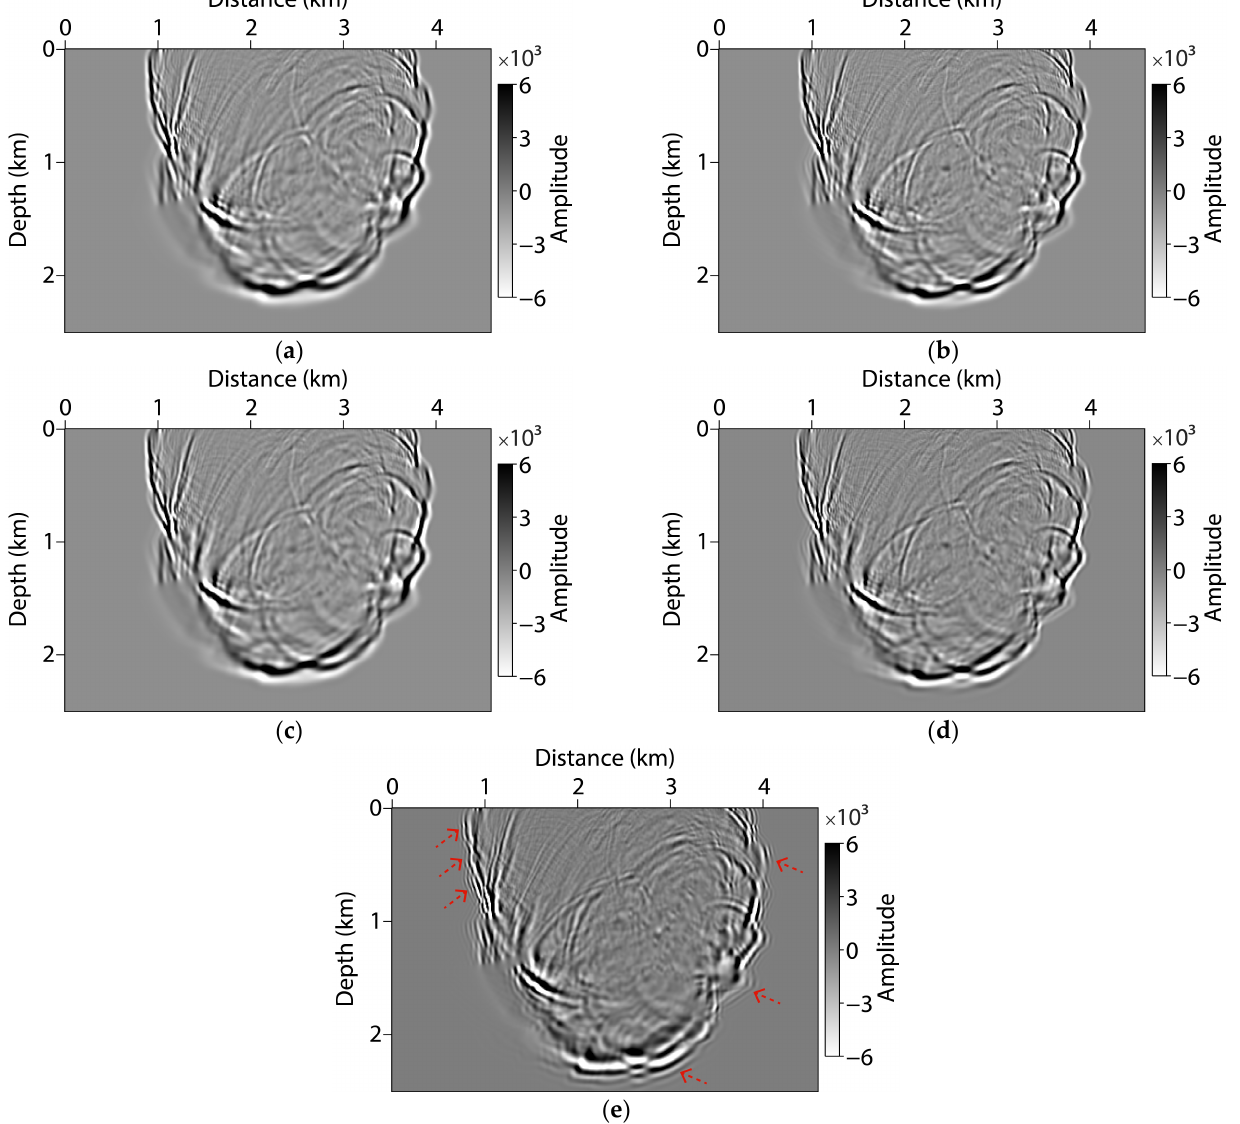
Figure 7. Snapshots of the Marmousi model at 0.5 s. They are simulated by: ( a ) CFD4 scheme, ( b ) CFD6 scheme, ( c ) OCFD4 scheme (0.5 π ), ( d ) OCFD4 scheme (0.75 π ), and ( e ) OCFD4 scheme ( π ), respectively. The red arrows indicate the dispersion